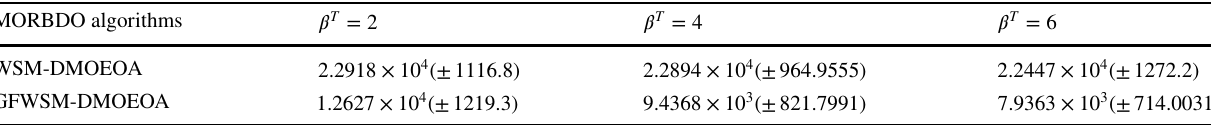
Table 14 The computational time (s) of the two MORBDO algorithms on the third MORBDO test example with different target reliability lev- els. Each result is in the form of mean ± standard deviation MORBDO algorithms 𝛽 T = 2 𝛽 T = 4 𝛽 T = 6 WSM-DMOEOA